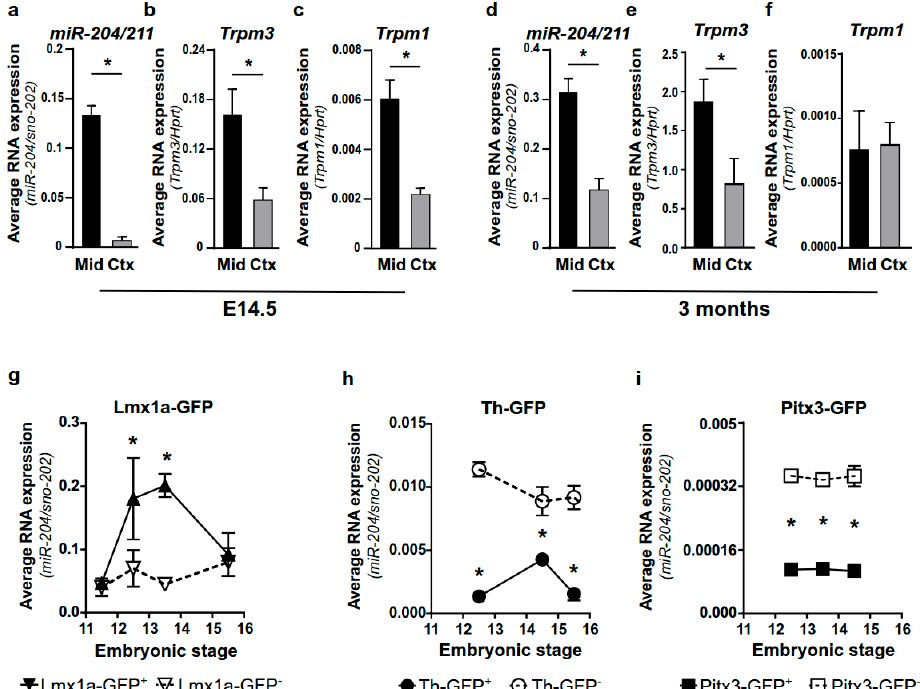
Figure 1. miR-204/211 is enriched in a DA precursor subpopulation during midbrain development. ( a – f ) TaqMan assay for miR-204/211 ( a , d ) and qPCR for Trpm3 ( b , e ) and Trpm1 ( c , f ) on microdissected midbrain (Mid) and cortex (Ctx) at E14.5 ( a – c ) or 3 months ( d – f ). miR-204/211 values are normalized to sno-202 expression, while mRNA levels are normalized on the reference mRNA hypoxanthine phosphoribosyl transferase (Hprt). Bars represent mean ± SD of 2 −Δ Ct values from four animals. * p < 0.05 (unpaired t-test with Welch’s correction). ( g – i ) TaqMan assay for the expression of miR-204/211 in FACS-purified GFP + and GFP - cells from Lmx1a-GFP ( g ), Th-GFP ( h ), and Pitx3-GFP ( i ) reporter mice at different developmental stages. Data are normalized to the average of the reference sno-202 and represent the mean ± SD of 2 − ∆ Ct values from three independent experiments. * p < 0.05 of GFP + with respect to GFP − (two-way ANOVA followed by